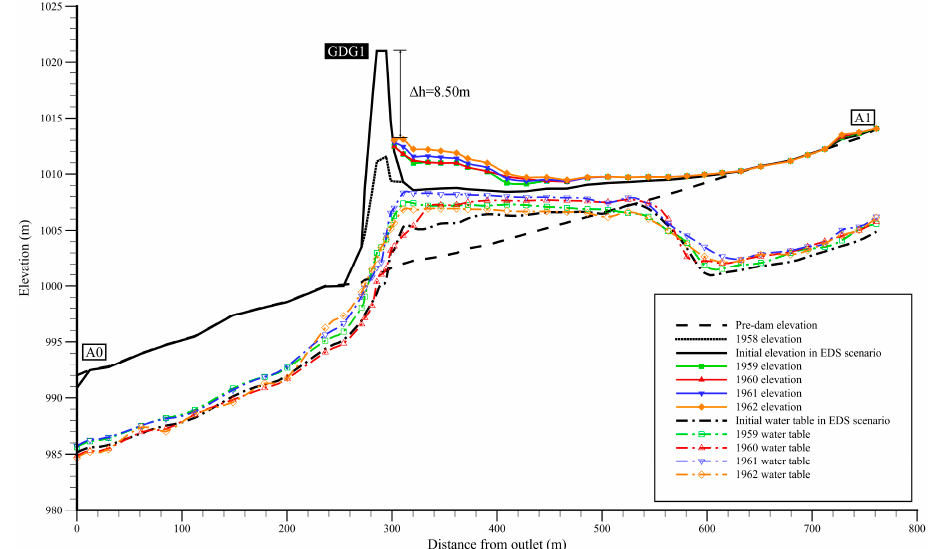
Figure 9. Surface elevation changes and water table changes of GDG1 dam-controlled reach during EDS scenario. Note that the simulation results in the end of month 11 of each year were used for comparison.